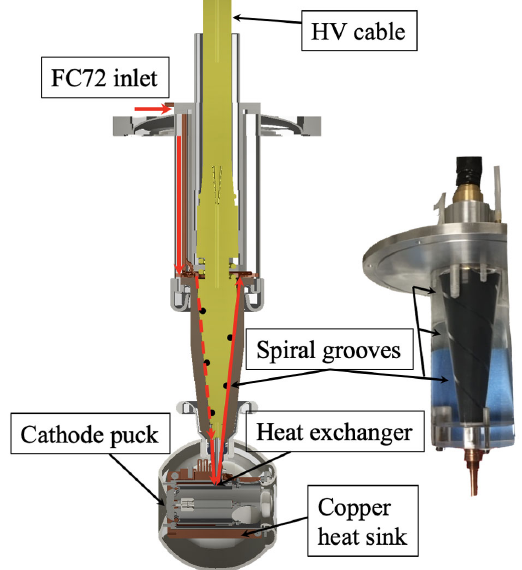
FIG. 6. The left figure is the cross view of the modified plug with the HV feedthrough and electrodes. The FC72 flow path is shown in red arrow. The right figure is the picture of the modified plug in a transparent acrylic container to test the grease